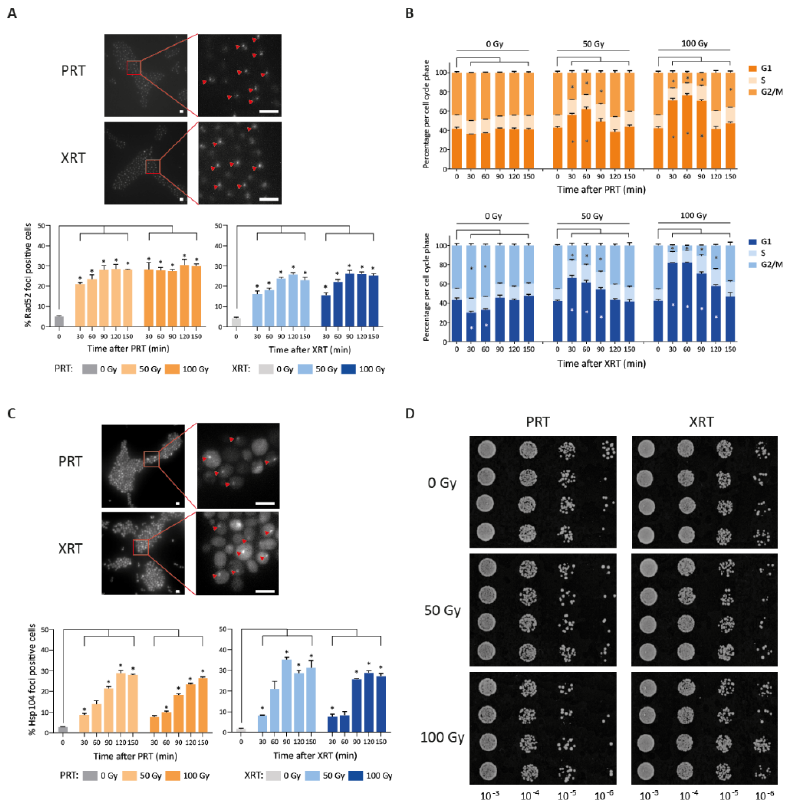
Figure 4. Proton (PRT) and photon (XRT) radiotherapy induce DNA damage and protein damage in S. cerevisiae . ( A ) Repair kinetics after photon and proton irradiation. Example image of Rad52 foci 90 min after 100 Gy irradiation (strain LAV87) (top). Scale bars represent 5 μ m. The percentage of Rad52 foci positive cells is depicted over time after 50 Gy or 100 Gy of PRT and XRT (bottom). All data are represented as the mean ± SEM for n = 3. For each replicate, at least 1500 cells were analyzed per condition. p ‐ values were calculated using ANOVA with multiple comparisons test compared to the 0 min control. * p ‐ values < 0.05. ( B ) Cell cycle distribution after proton (top) and photon (bottom) irradiation. The percentage of the population in G1, S and G2/M is depicted. p ‐ values were calcu ‐ lated using ANOVA with multiple comparisons test compared to the 0 min control. * p ‐ values < 0.05. ( C ) Example image of Hsp104 foci 90 min after 100 Gy irradiation (strain LAV91) (top). Scale bars represent 5 μ m. The percentage of Hsp104 foci positive cells over time is depicted after 50 Gy and 100 Gy of PRT and XRT (bottom). All data are represented as the mean ± SEM for n = 3. For each replicate, at least 1500 cells were analyzed per condition. p ‐ values were calculated using ANOVA with multiple comparisons test compared to the 0 min control. * p ‐ values < 0.05. ( D ) Spotting assay with proteasome inhibitor MG ‐ 132 in combination with 50 Gy or 100 Gy proton or photon radiation. Additionally, 10 ‐ fold dilutions of mock irradiated or irradiated cells are spotted on YPD containing 50 μ M MG ‐ 132. Images were taken after 48 h of incubation at 30 °C. Next, we investigated possible changes in cell cycle dynamics after irradiation. Cell cycle arrest is generally recognized as an indispensable part of the DNA damage response. For example, previous studies showed that Gamma ‐ irradiated synchronized yeast cul ‐ tures show a prolonged G1 arrest that is dose ‐ dependent and proportional to the amount of DNA damage [51]. In line with this previous result, we found that irradiation induced a dose ‐ dependent increase in cells that are in the G1 phase, independent of the irradiation type (Figure 4B). The G1 arrest became less pronounced after 90 min for both PRT and XRT after 50 Gy and 100 Gy, although the 100 Gy treatment resulted in slightly more cells remaining in G1.